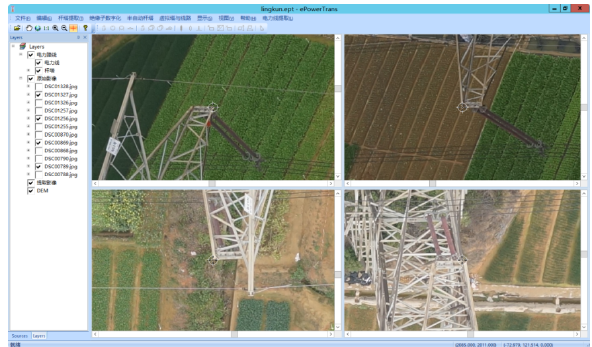
Figure 5. Main UI of the applications for 3D reconstruction of power pylons and lines.